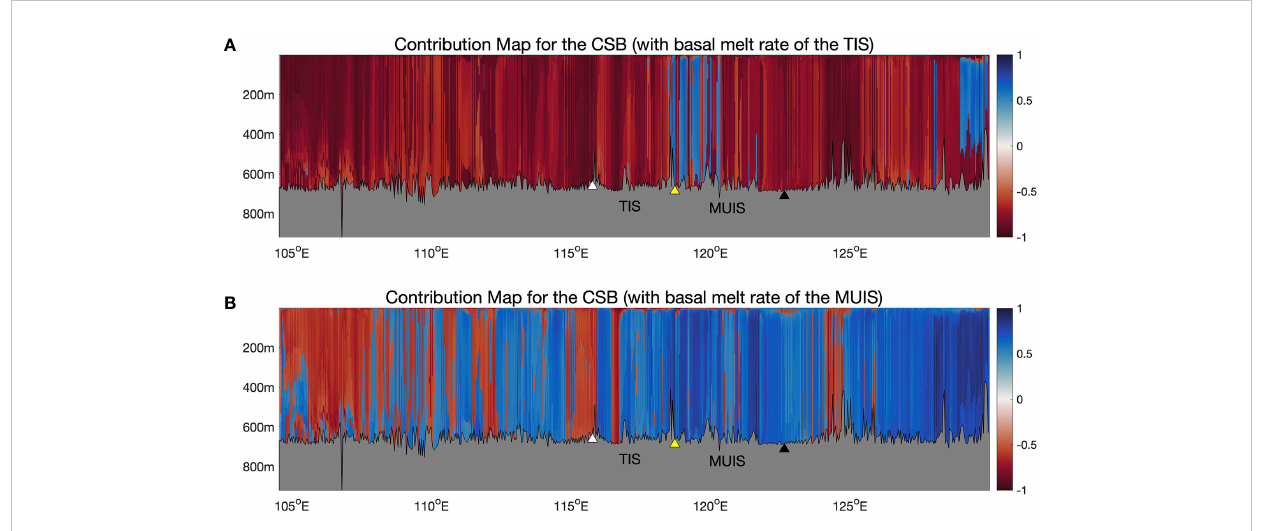
FIGURE 8 Depth pro fi les of C eddy (or C tide ) along the CSB transect, grey regions mark the sea fl oor topography. Top (A) the estimated contributions from eddies (in red) and tides (in blue) calculated from the WTC between the heat transport at each grid cell and the basal melt rate of TIS. Bottom (B) is calculated from the WTC between the heat transport at each grid cell and the basal melt rate of MUIS. The demarcation point between TIS and MUIS is marked by a yellow triangle. The western boundary of the TIS front is marked by a white triangle (around 115.8° E), and the eastern boundary of the MUIS front is marked by a black triangle (around 122.7° E). Figure used cmocean (Thyng et al.,